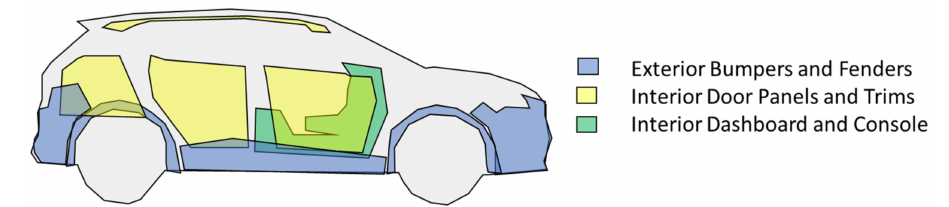
Figure 3. First application scope of the three main vehicle plastic